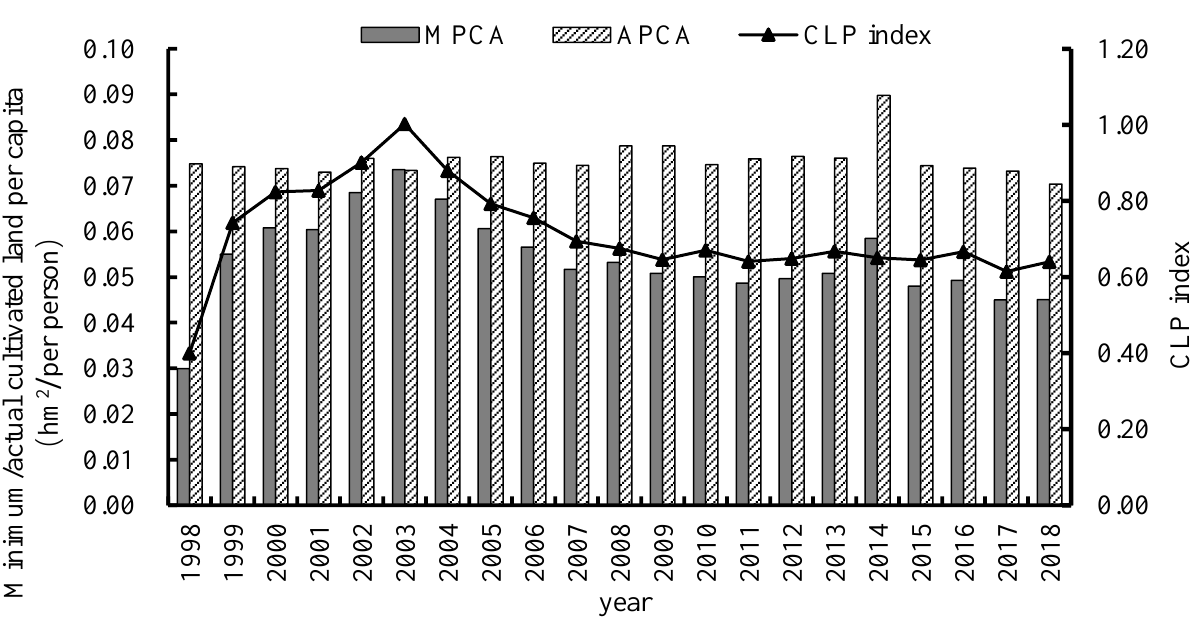
Figure 2. Change of MPCA, APCA and CLP index in the AALYR.